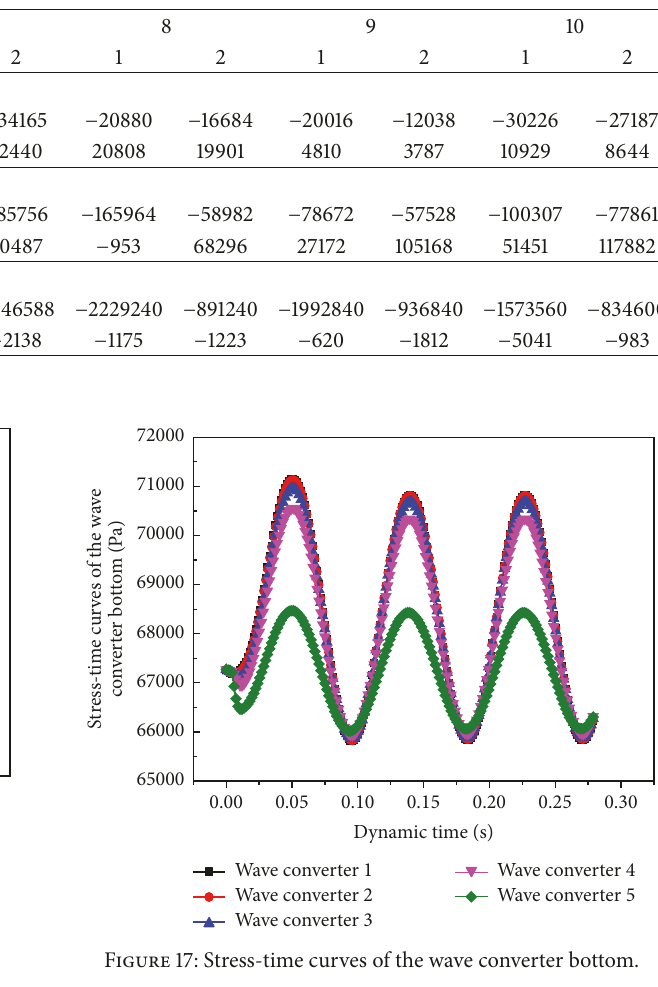
(1) After the deployment of wave converters, the peak absolute values of the bending moment, shear force, and axial force decrease generally. The decrease of the peak internal forces means that smaller size and less steel are needed in the design of the structure, which could help reduce the